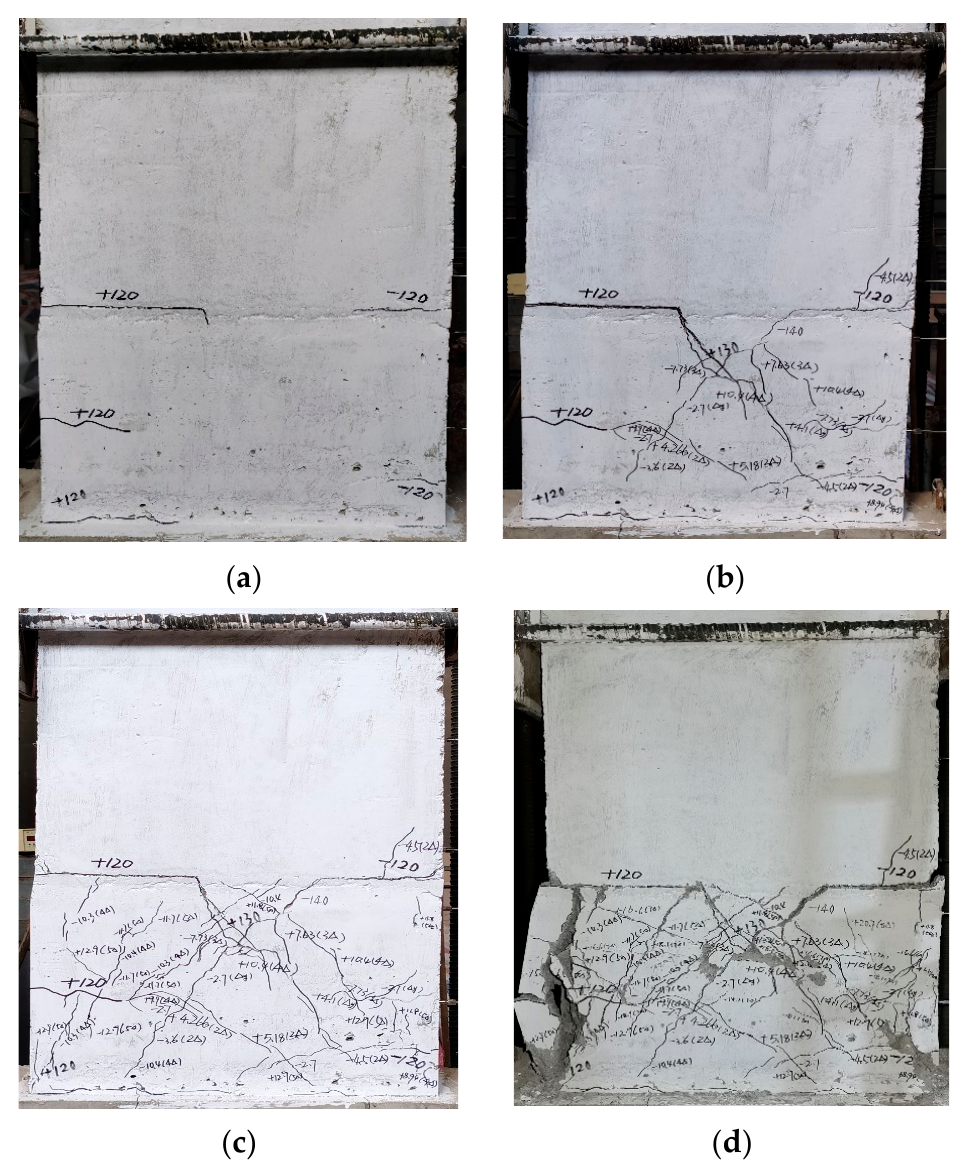
Figure 8. The evolution of the cracks for PW4 during the various loading cycles: ( a ) crack load; ( b ) yield load; ( c ) peak load; and ( d ) ultimate load.